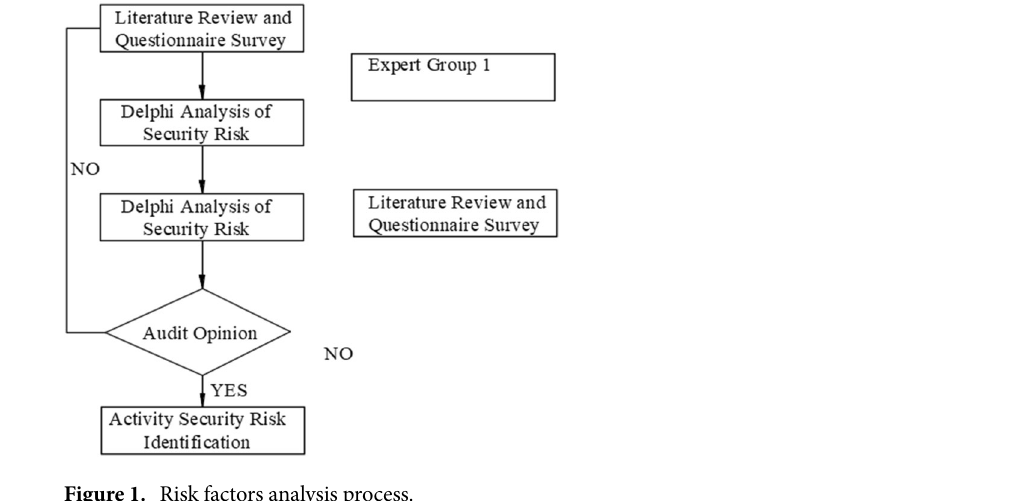
Figure 1. Risk factors analysis